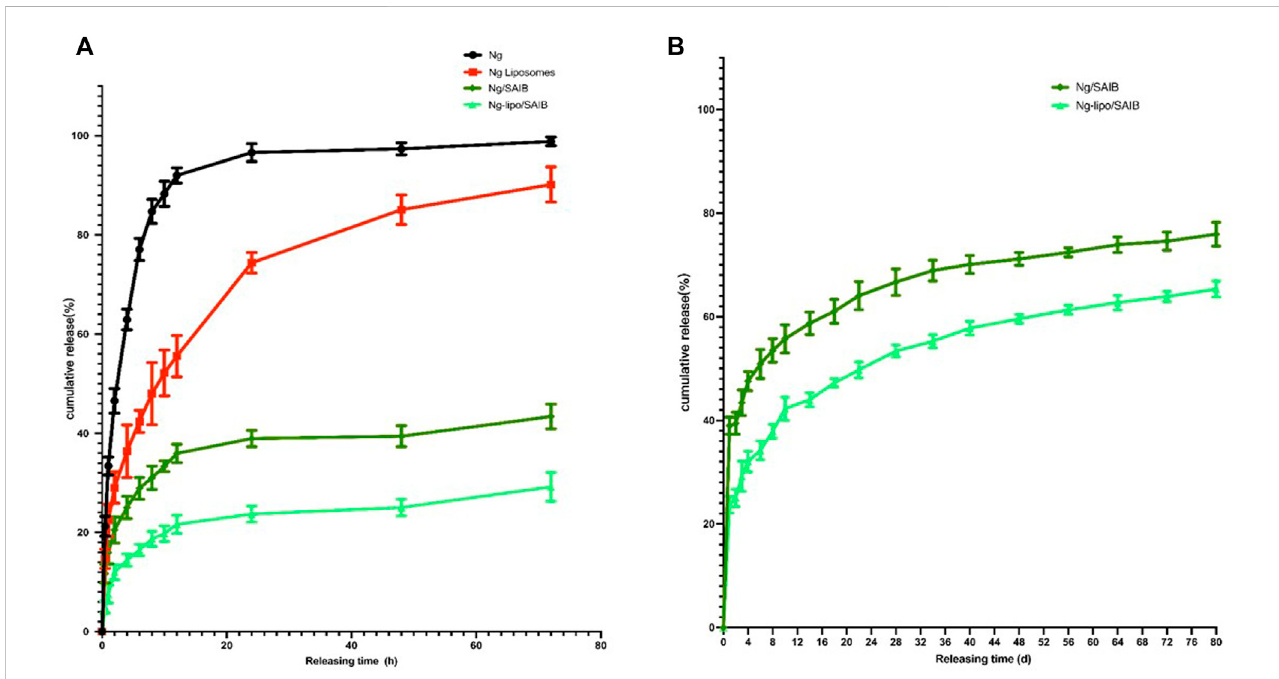
FIGURE 3 In vitro releases of Ng, Ng liposomes, Ng/SAIB, and Ng-lipo/SAIB during 1 – 3 days (A) and Ng/SAIB, Ng-lipo/SAIB during 3 – 80 days (B) from depots at 37 ° C. ( n = 3).